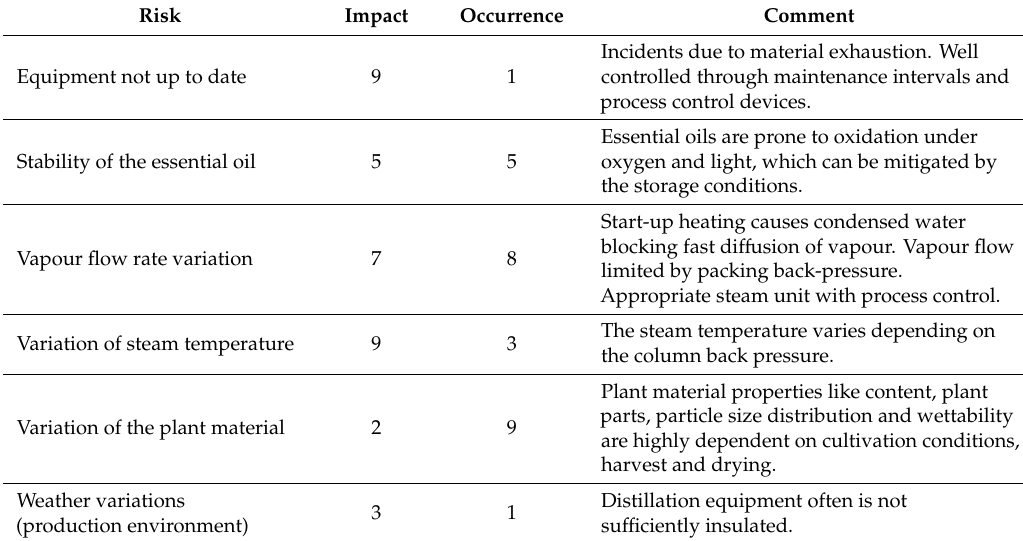
Table 1. QbD initial risk assessment: